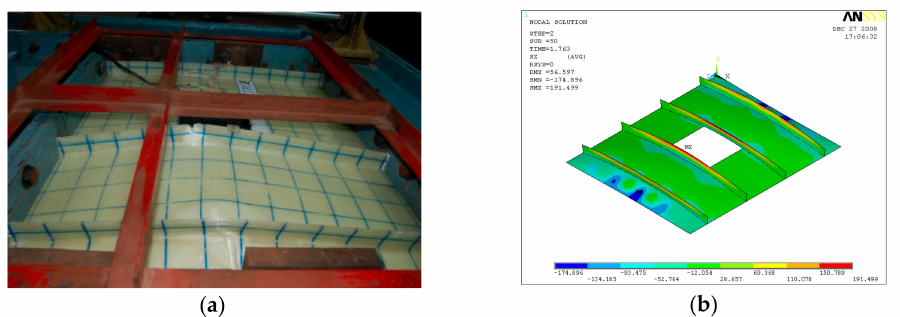
Figure 18. Failure of LSTPO2. ( a ) Experiment ( b )